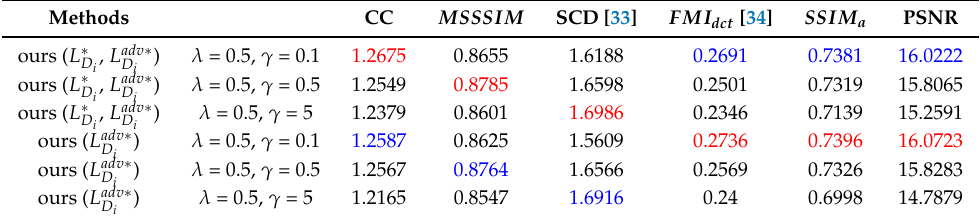
Table 3. The average values of quality metrics for 20 fused images of our RoadScene dataset. Different values of λ and γ are used in the loss function. The best values are indicated in red and the second best values are indicated in blue.